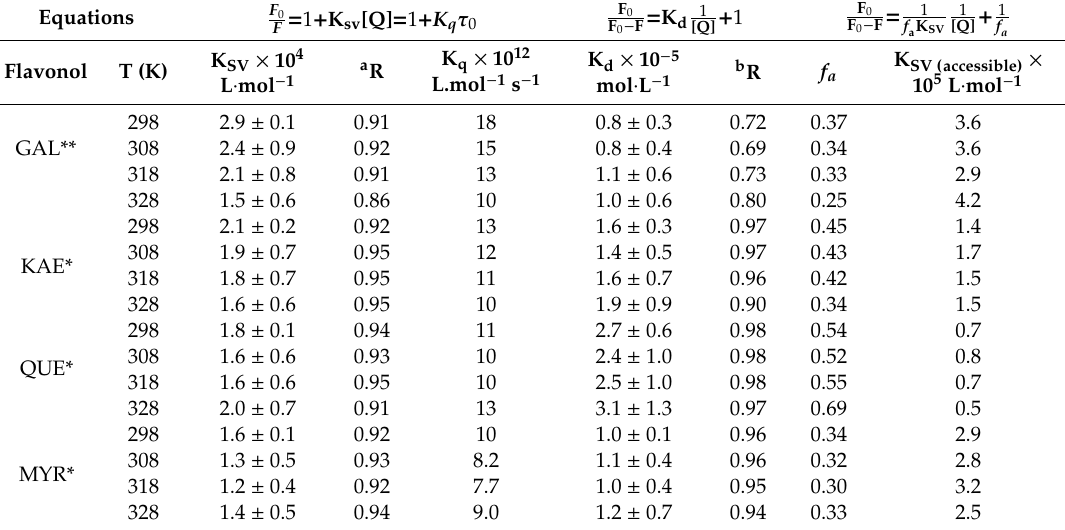
= Bimolecular d values. K q